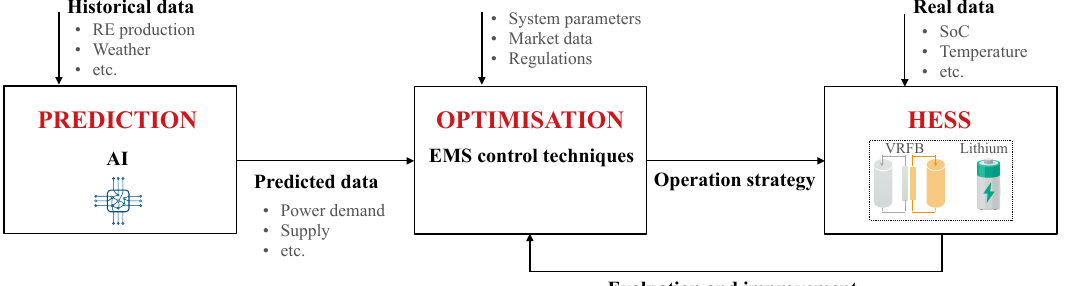
Figure 9. Real-time EMS architecture